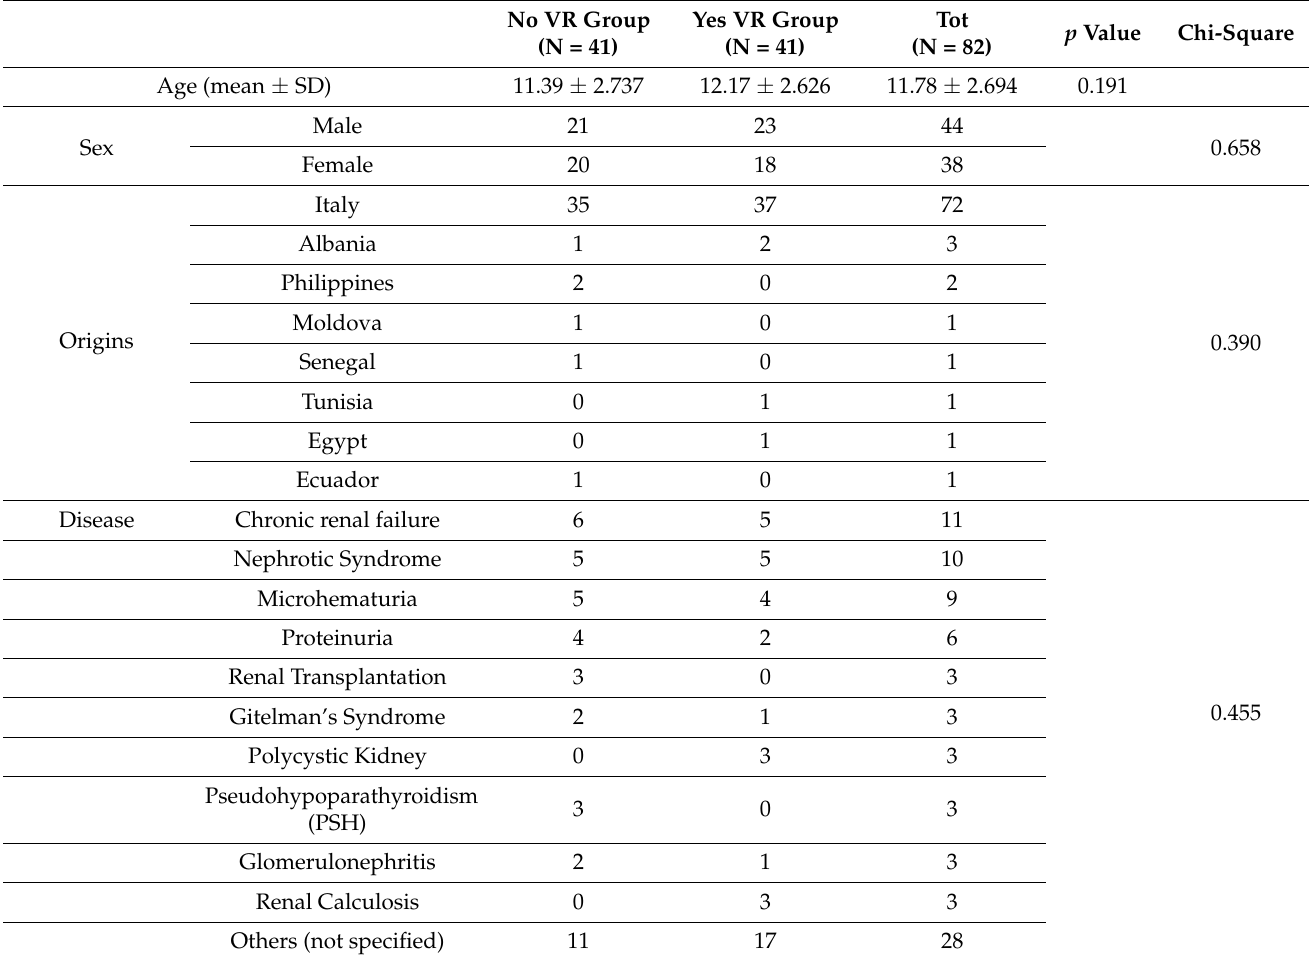
Table 1. Sample’s demographics and clinical